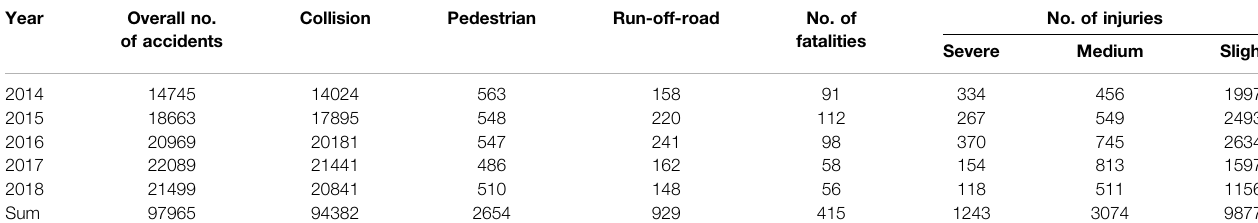
TABLE 9 | Descriptive statistics of 5-year accidents in Zarqa City.